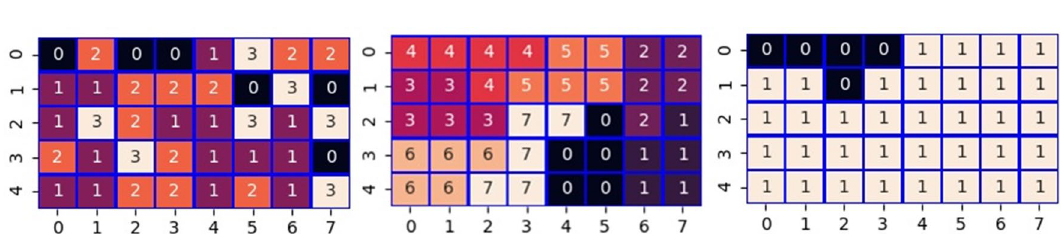
Figure 5. Gerrymandering with queen constraint. The left panel shows the distribution of the supporters where 1(0) means a cell that Party A(B) has an advantage over B(A). Middle panel shows the calculated correspondence between the cells and the 14 districts indexed from 0 to 13. The right panel shows the assignment of seats based on the calculated districting.